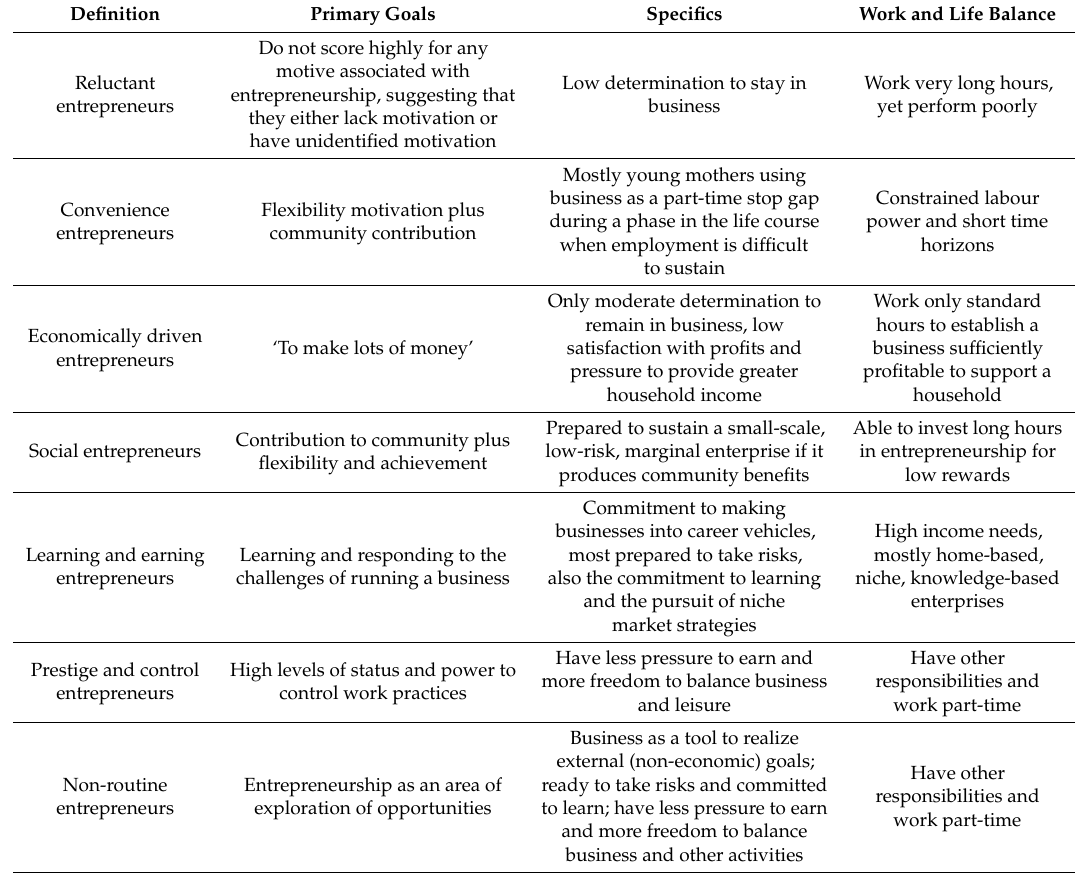
Table 1. Variety of entrepreneurs according to motivation and the work and life